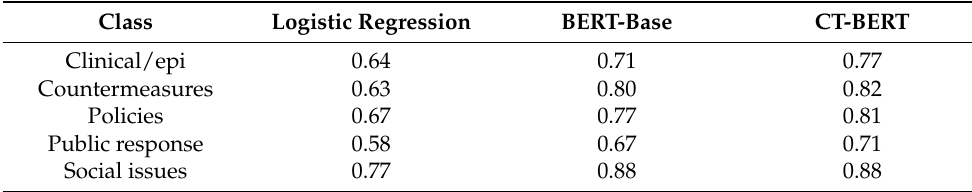
Table 3. Topic classification accuracy